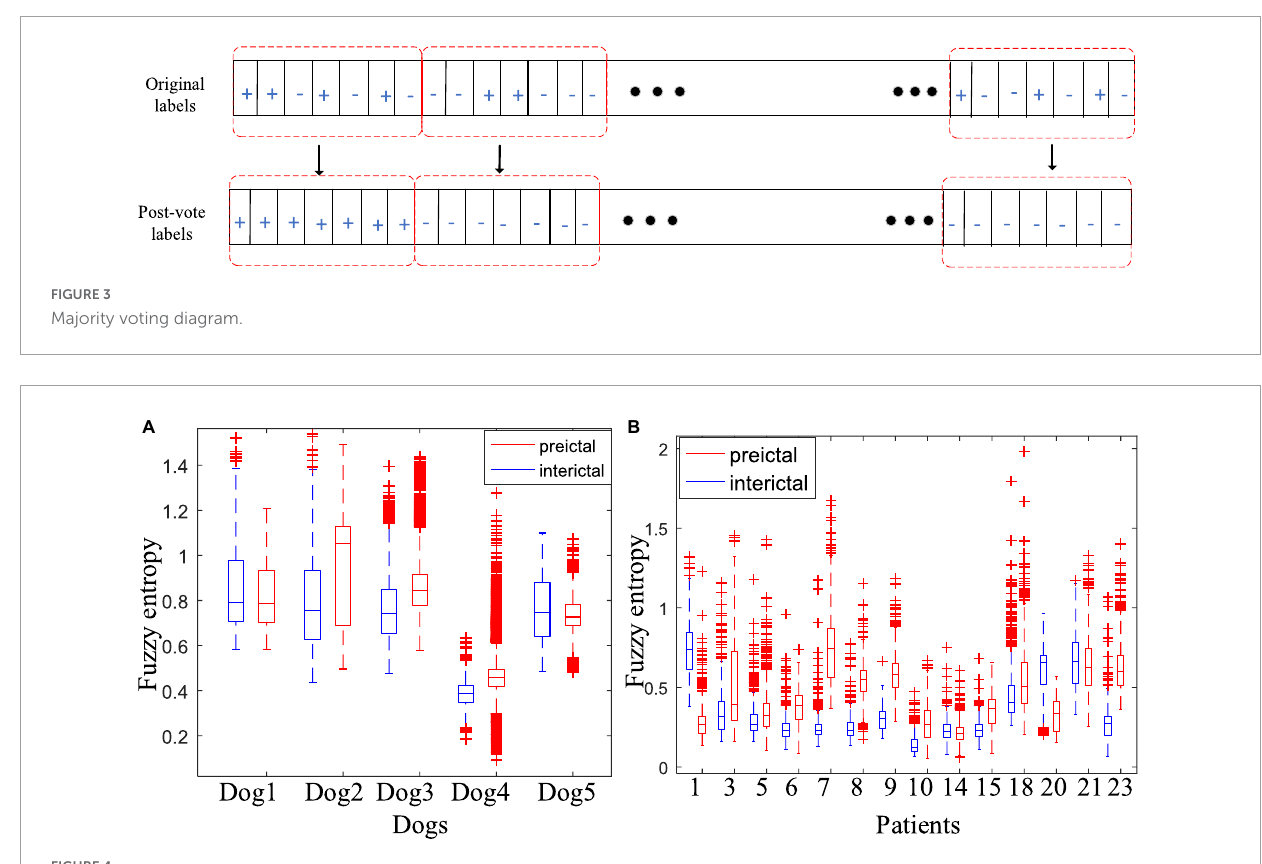
FIGURE4 Comparison of the fuzzy entropy between the preictal and interictal states. (A) Is the fuzzy entropy for dogs in the Kaggle dataset and (B) is for patients in the CHB-MIT dataset.